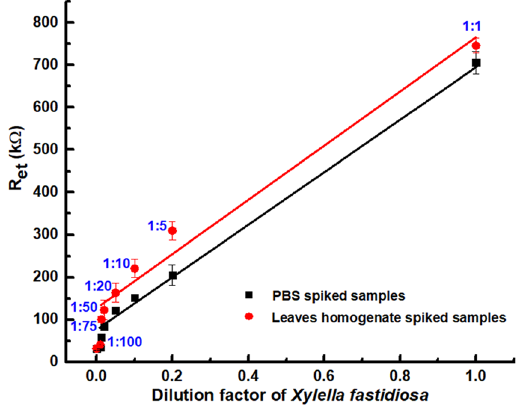
Figure 5. Calibration curves for Xylella fastidiosa in a EIS device. Black line is related to serial dilution of stock solution on PBS; red line is related to spiked leaves homogenate samples.